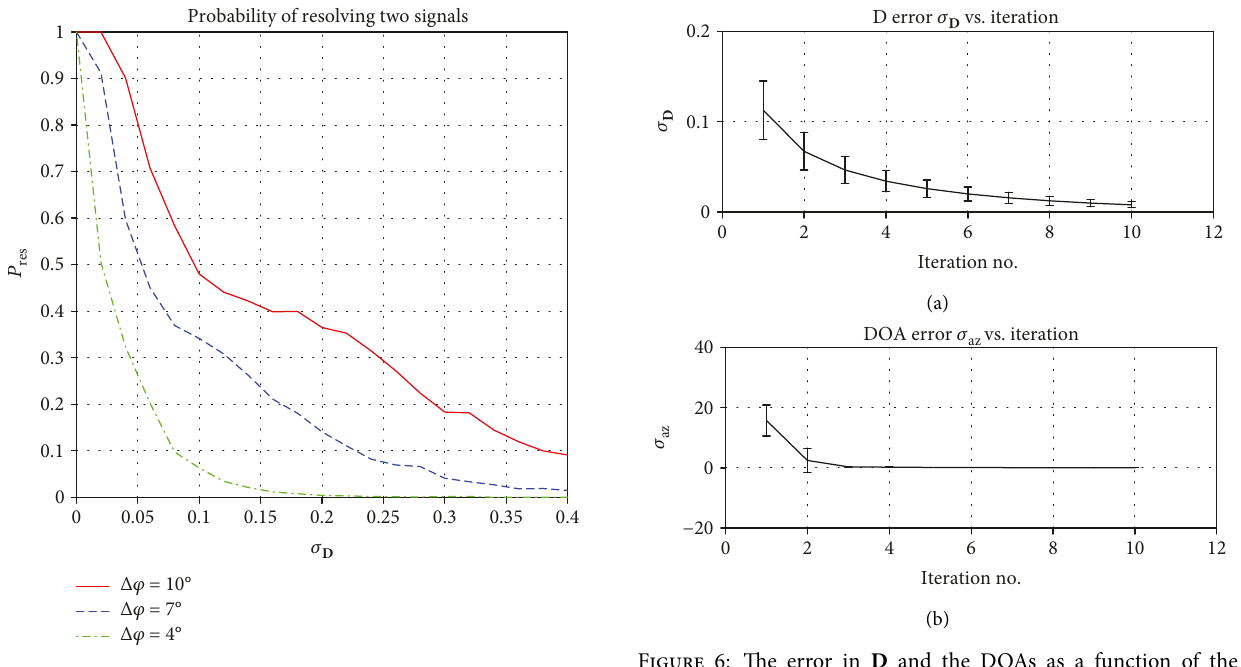
Figure 5: The probability of resolving two equal power signals as function of the mismatch between the true and assumed D , for different angular separations Δ𝜙 .